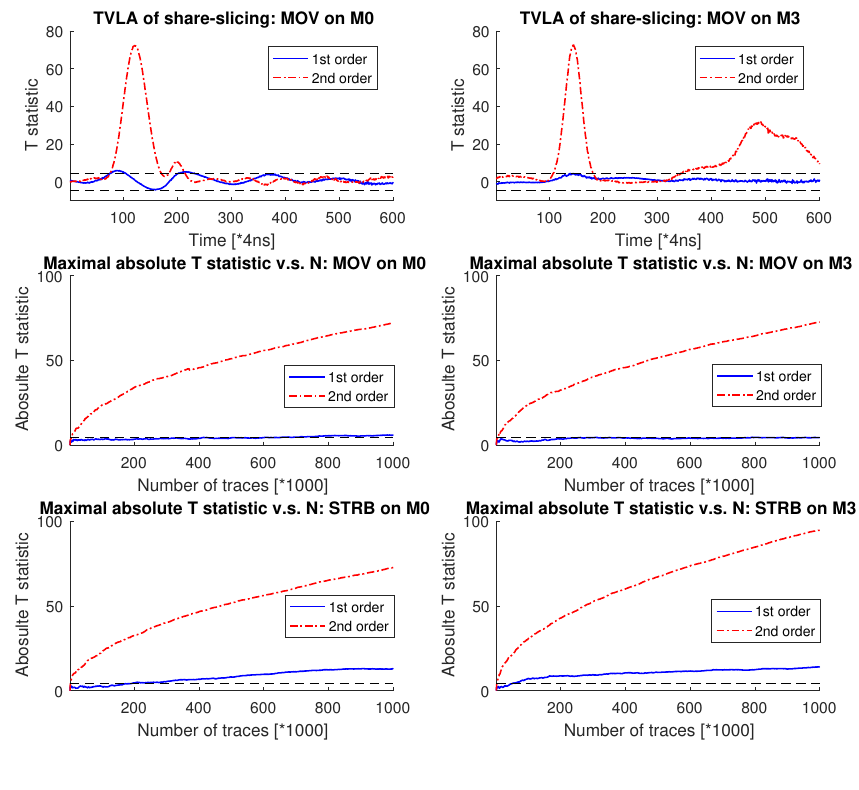
Figure 5: Instruction-wise leakage analysis: